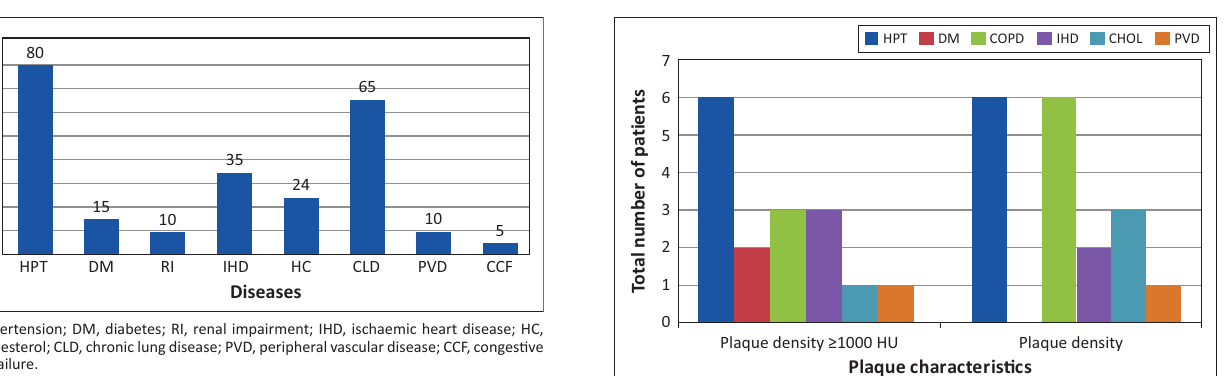
cardiac failure. FIGURE 4: Comorbid factors prior to TAVI.